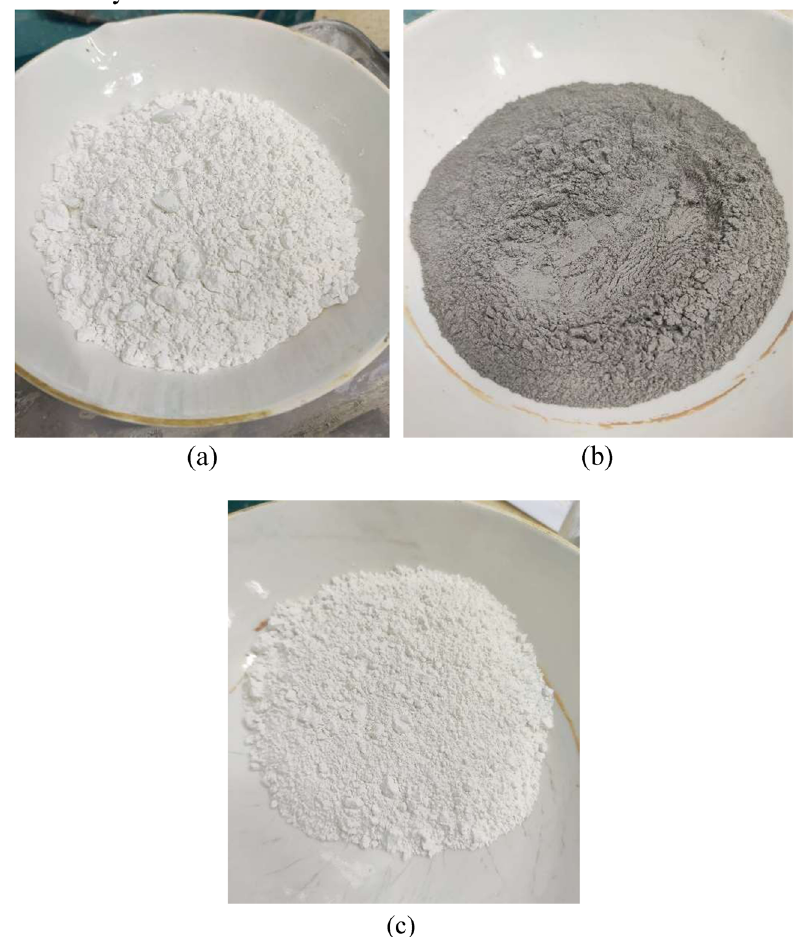
Figure 1: Cementitious materials. ( a ) CG, ( b ) FA, and ( c ) slag.